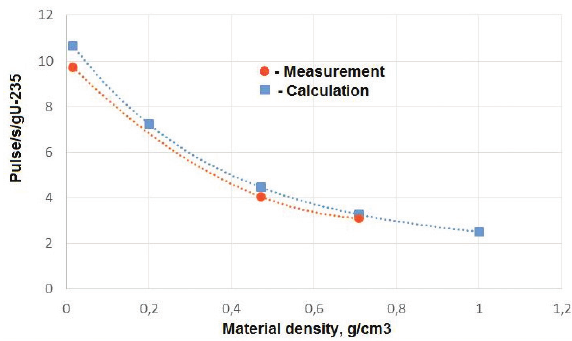
Figure 5. Dependence of the count intensity in the 185.7 keV peak on the density of the waste material in the form of cellulose with a small content of uranium (~1 g of 235